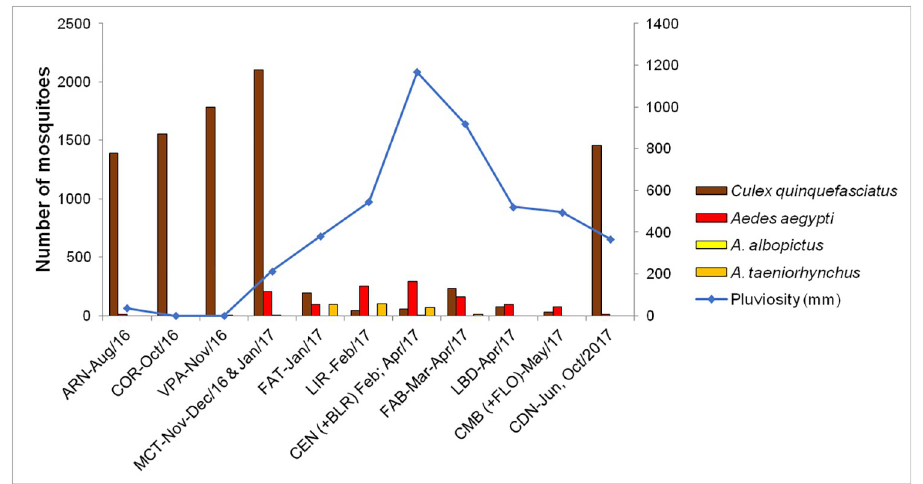
Fig 2. Density of adult mosquitoes collected in the premises sampled in S ã o Luı ´ s, MA, Brazil, and accumulated rainfall (30 days prior to the first collection plus days of mosquitoes capture in each neighborhood). ARN, Areinha (33 days); COR, Core´ia (33 days); VPA, Vila Passos (46 days); MCT, Monte Castelo (98 days); FAT, Fa´tima (39 days); LIR, Lira (39 days); CEN, Centro + BLR, Belira (85 days); FAB, Fabril (64 days); LBD, Liberdade (40 days); CMB, Camboa + FLO, Floresta (40 days); CDN, Coroadinho (90 days). Hydrological Information System, Agência Nacional de Águas (ANA [National Water Agency]) http://www.snirh.gov.br/hidroweb/serieshistoricas [30].